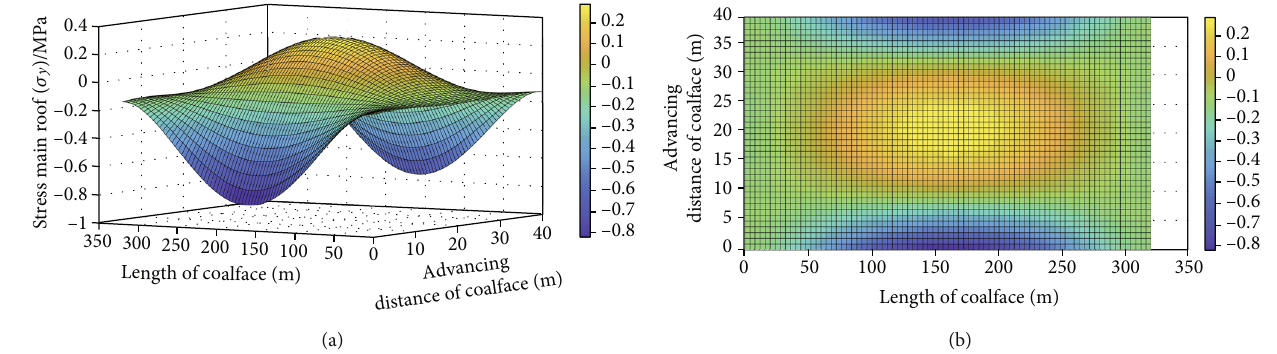
fi rst breaking of the main roof: (a) three-dimensional distribution of the stress σ y upon the